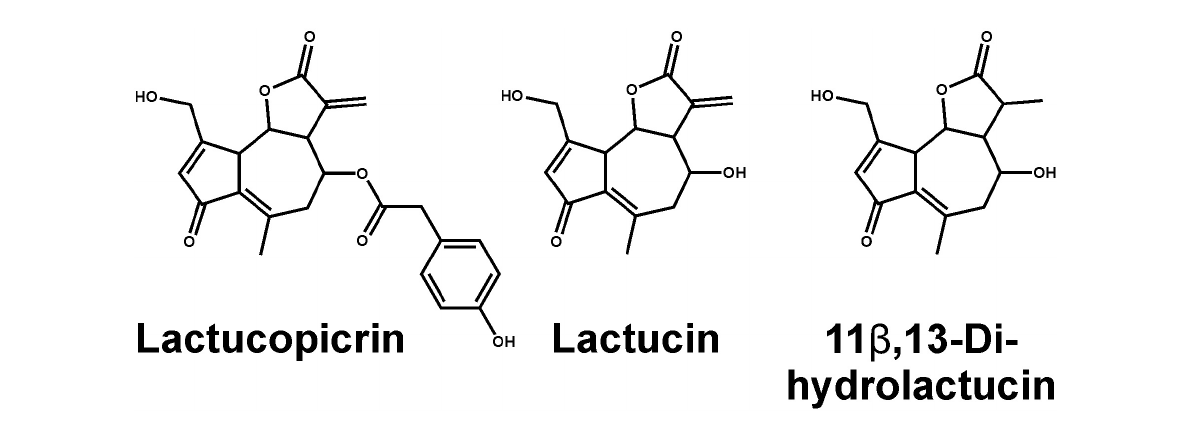
FIGURE1 Chemical structures of main bitter compounds from chicory. Shown are lactucopicrin used for TAS2R screening (left) , lactucin (middle) , and a naturally occurring hydrogenated form of lactucin, 11 β ,13-dihydrolactucin (right) .